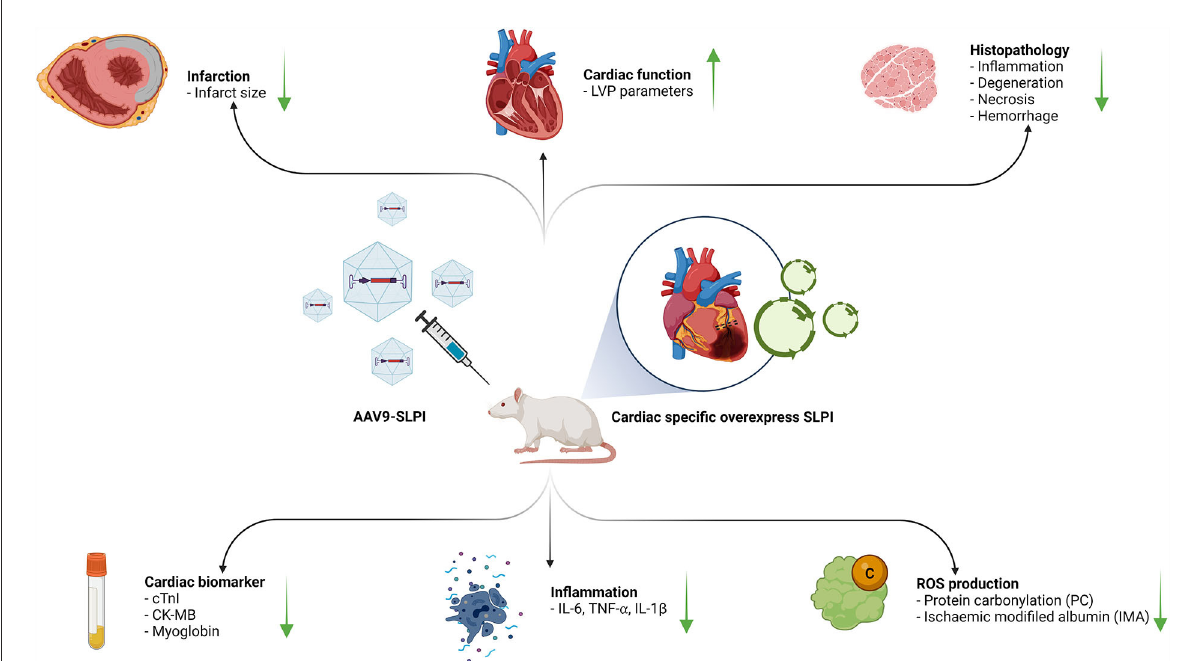
FIGURE7 A schematic diagram of the major findings in this study. The cardiac selective overexpression of SLPI by using AAV9-SLPI. Overexpression SLPI could provide the cardioprotective effect associated with the attenuation of inflammation, intracellular ROS production related to reducing infarct size and cardiac biomarkers and improving cardiac function. This figure generated by BioRender with access URL https://app.Biorender.